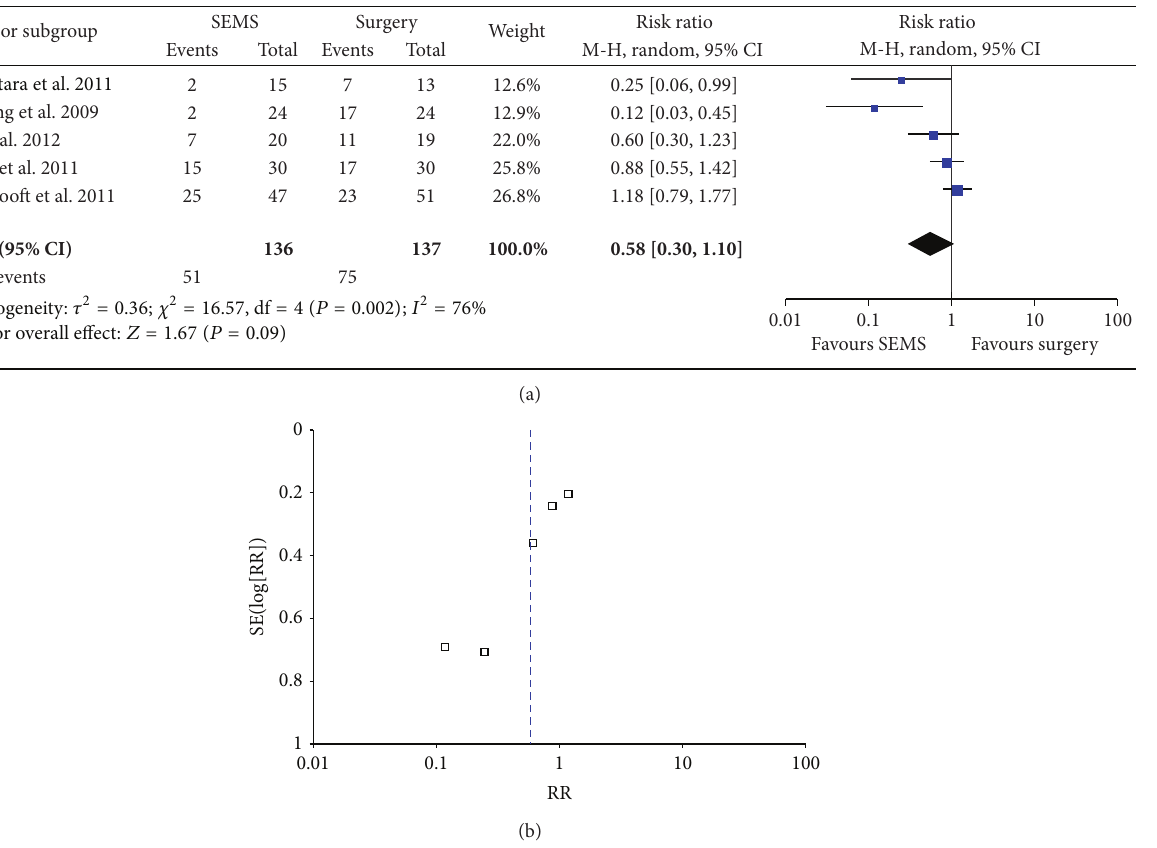
Figure 5: Forest plot and funnel plot of overall complication